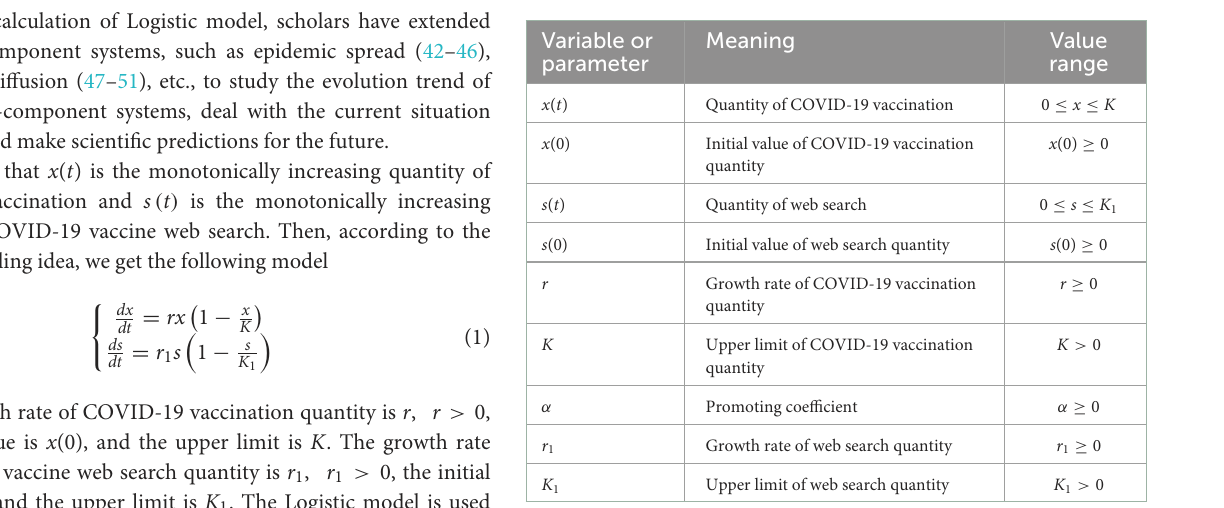
TABLE 1 Meaning of model variables and